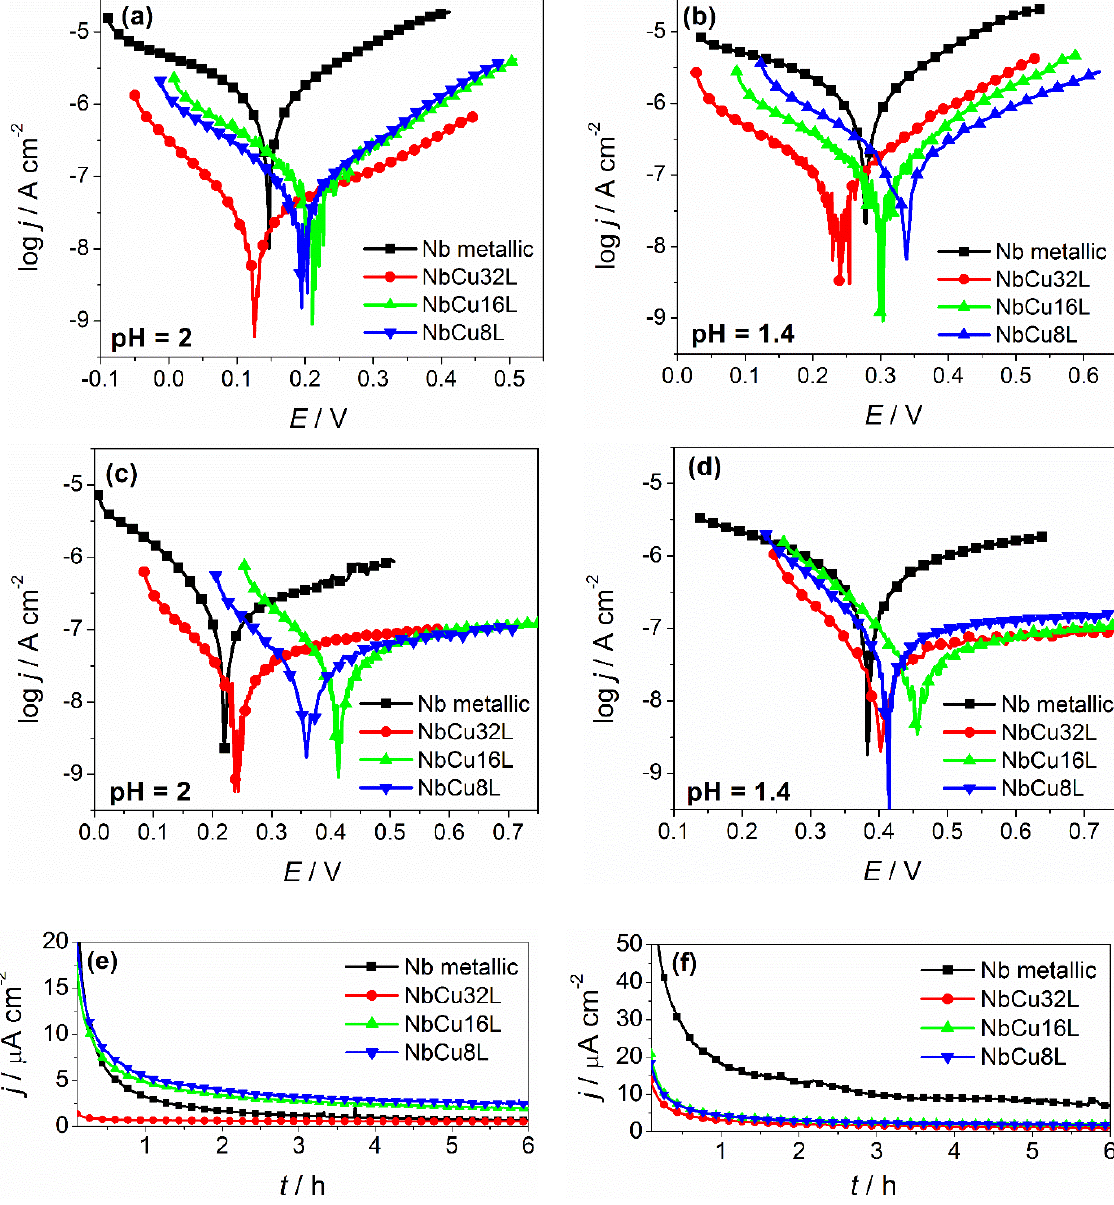
Figure 3. Potentiodynamic polarization curves (v = 1 mV s − 1 ) measured in O 2 -saturated solutions at 90°C for metallic Nb and Nb coatings on Cu: ( a ) before and ( c ) after AST in 0.005 M H 2 SO 4 + 0.1 ppm F − (pH = 2); ( b ) before and ( d ) after AST in 0.05 M H 2 SO 4 + 0.1 ppm F − (pH = 1.4); current transients during AST in the test solutions at ( e ) pH = 2 and ( f ) pH = 1.4.